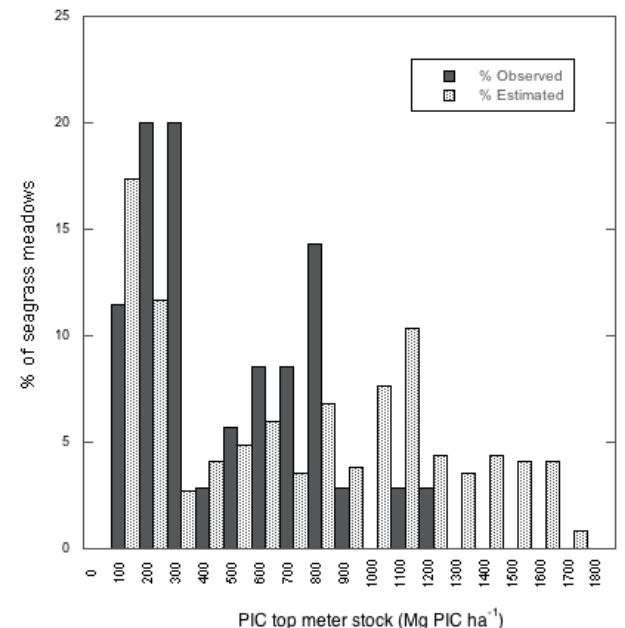
Figure 2. Frequency distribution of observed (i.e. sites reporting data to at least 1m, n = 35) and estimated (i.e. sites where shallower depths were reported, n = 368) PIC stocks (MgPICha − 1 ) in the top metre of seagrass